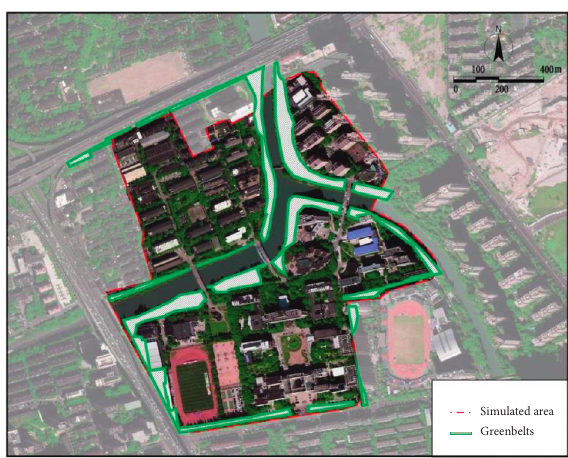
Figure 9: Diagram of greenbelts in the simulation zones.